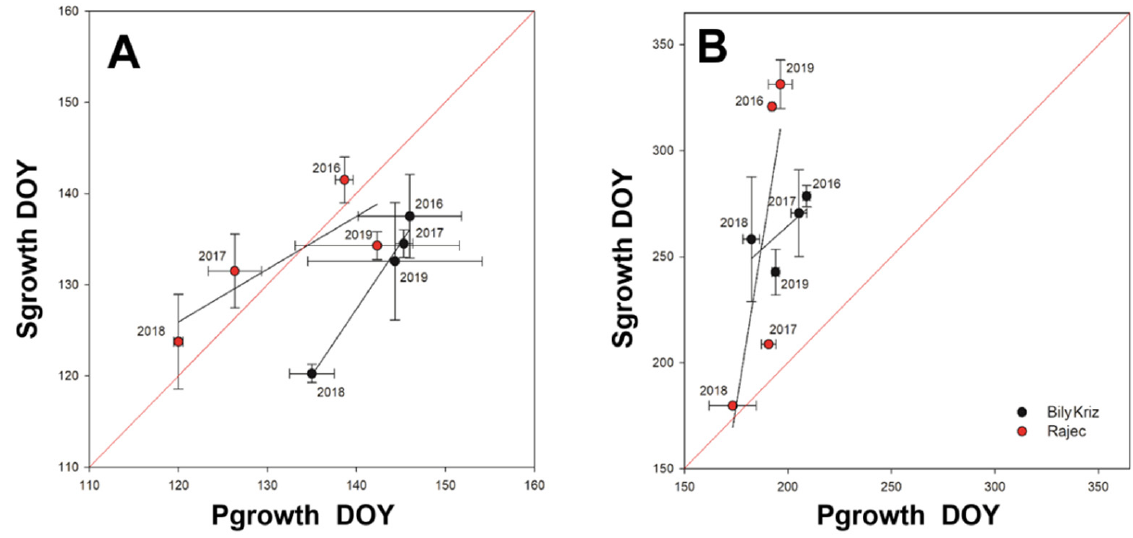
Figure 7. Correlation between onset ( A ) of primary (P growth ) and secondary growth (S growth ) and end of P growth and S growth ( B ) at the ESP Bily Kriz (black circles) and Rajec (red circles) in 2016–2019. The 1:1 red line is drawn for reference. Vertical and horizontal bars represent standard deviation.